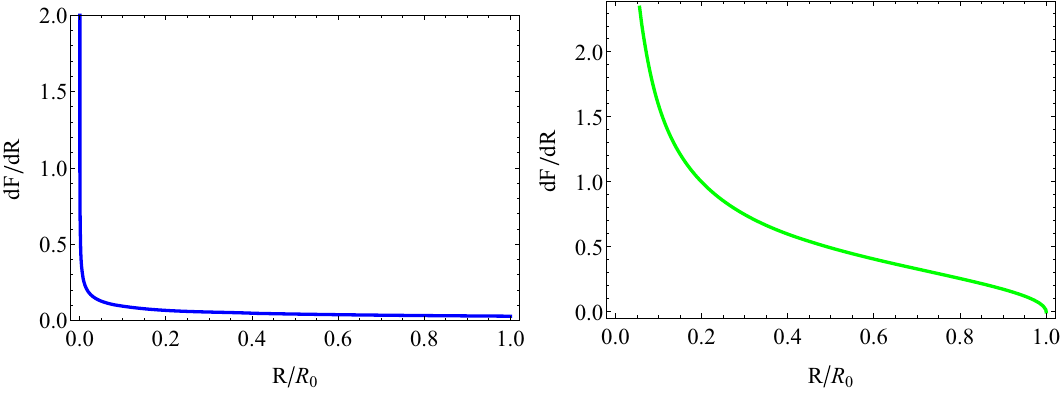
Fig. 6 The trend of dF / dR versus R / R 0 for m = 1 (left panel) and m = 0 (right